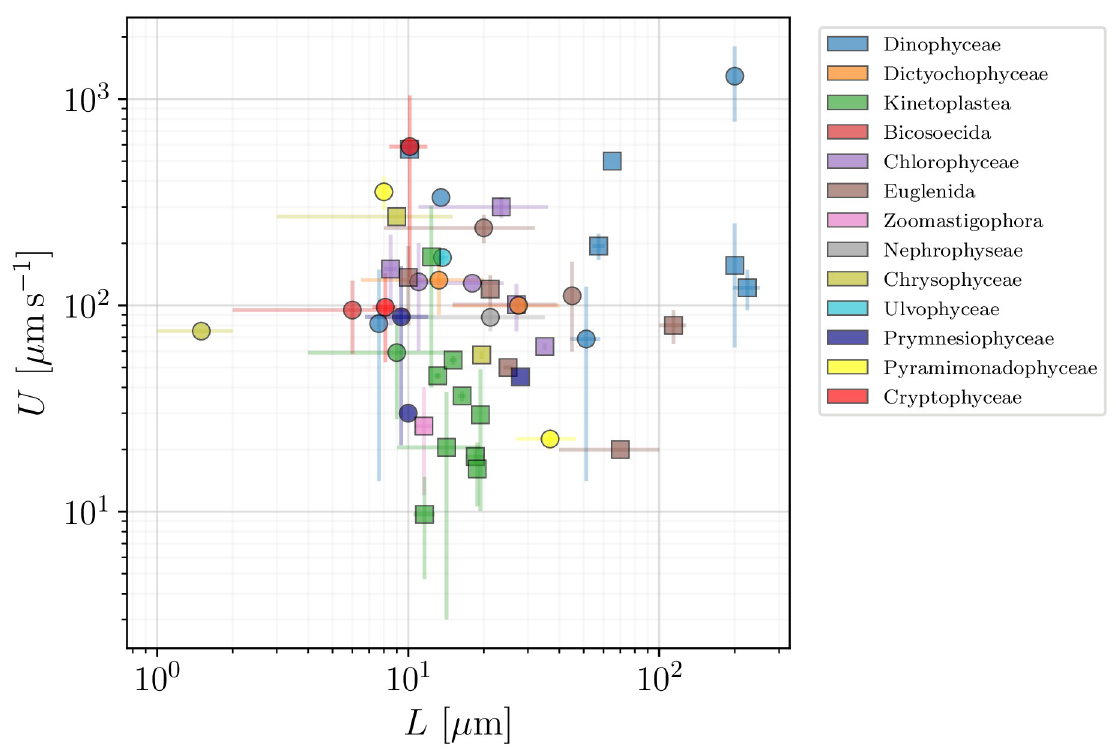
Fig 11. Swimming speed, U ( μ m s − 1 ), vs length of flagella, L ( μ m), for flagellated eukaryotes in our database (excluding spermatozoa and ciliates). Taxonomic classes are marked by colours. Wave-producers are again plotted in squares, while other flagellates are plotted in circles.